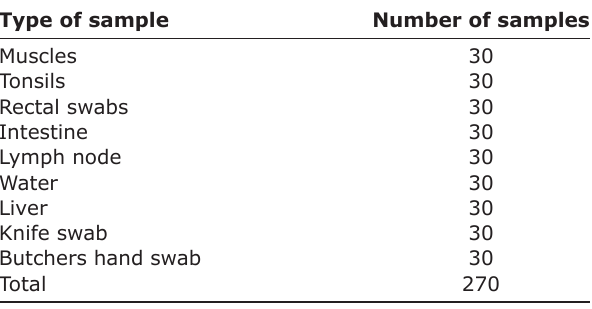
Table-1: Number of samples collected from different sources for isolation of Salmonella spp. Type of sample Number of samples